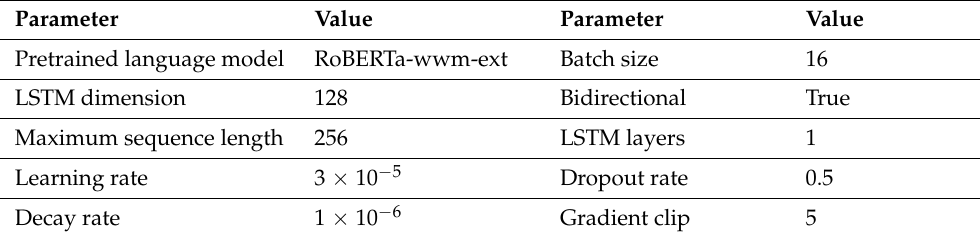
Table 4. Hyper-parameters of the deep learning-driven